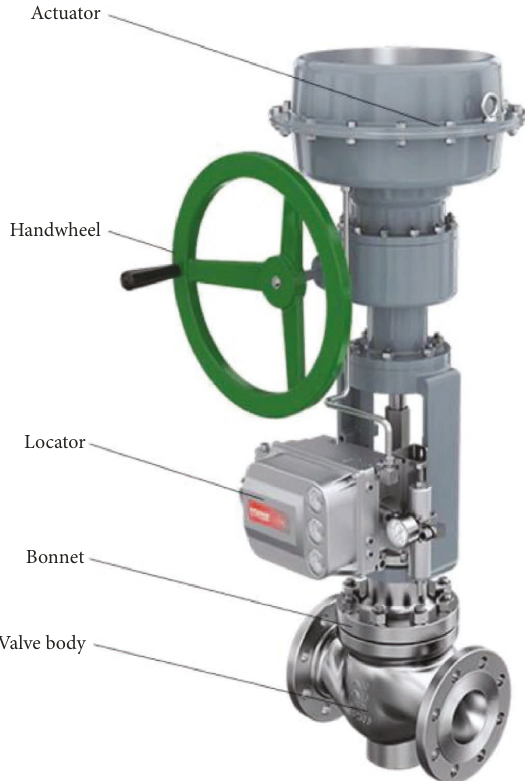
Figure 47: Noise-reducing double-stage cage control